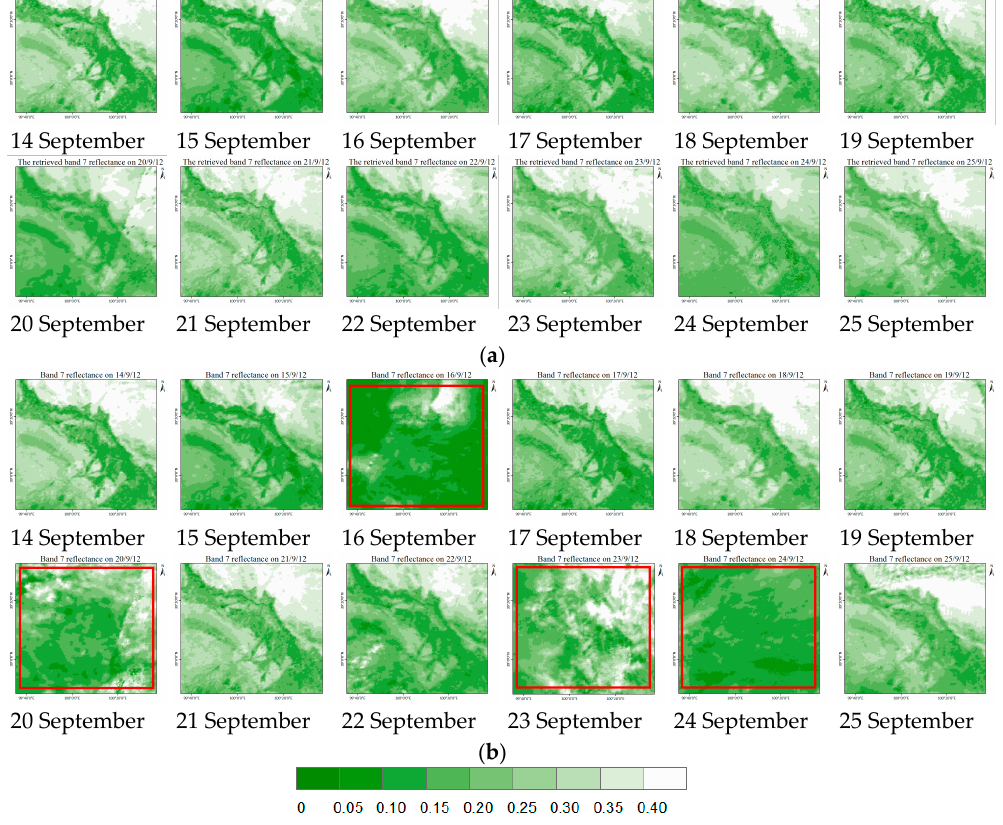
Figure 3. The Band 7 ( a ) retrieved reflectance and ( b ) observed reflectance for 12–25 September 2012. The retrieved band 7 reflectances show similar spatial distributions from 14 September to 25 September 2012, which means that the dataset has good quality and continuity through time, and the retrieved reflectance identifies the variation in the spatial distribution of the land surface according